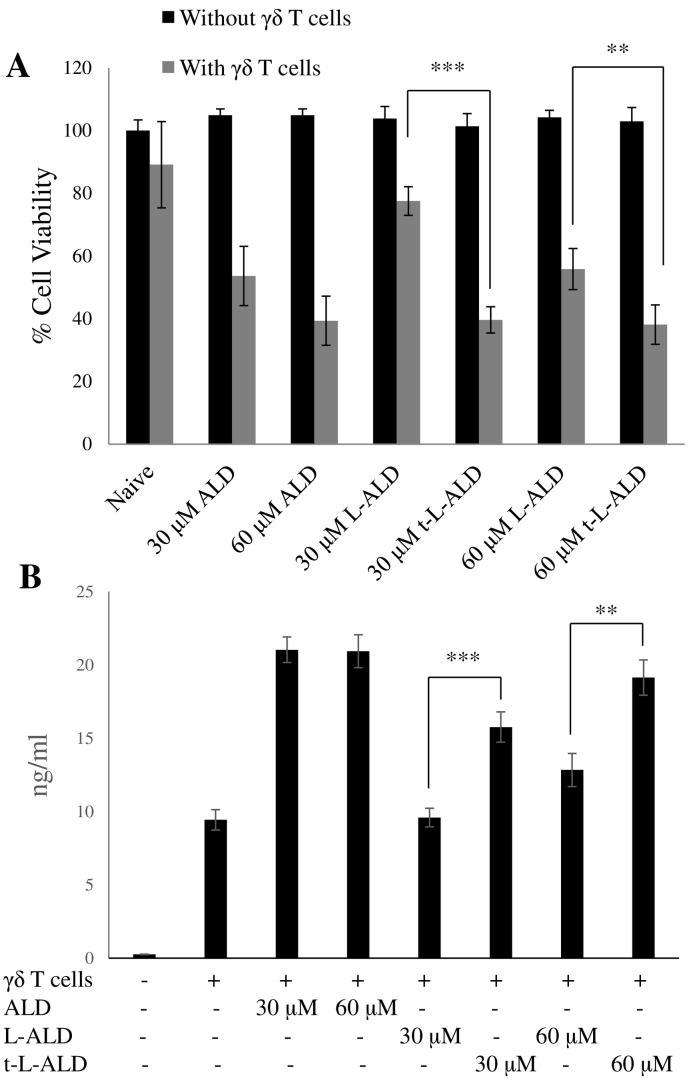
The ability of L-ALD and t-L-ALD to activate Vγ9Vδ2 T cells. (A) Cells were treated with ALD, L-ALD or t-L-ALD for 24 h at 30 or 60 μM for 24 h. The treatments were then removed and replaced with 2 × 105 γδ T cells for a further 24 h before a MTT assay was performed. t-L-ALD increased the sensitivity of A375Pβ6 cells to γδ T cells compared to L-ALD (grey bars). ALD, L-ALD or t-L-ALD did not cause cytotoxicity alone at the concentrations used (black bars). (B) IFN-γ ELISA was performed on supernatant removed prior to the MTT assay. t-L-ALD led to higher release of IFN-γ from γδ T cells than L-ALD. Data was expressed as means ± SD (n = 5). **P < 0.01, ***P < 0.001, (Student's t-test L-ALD vs. t-L-ALD).